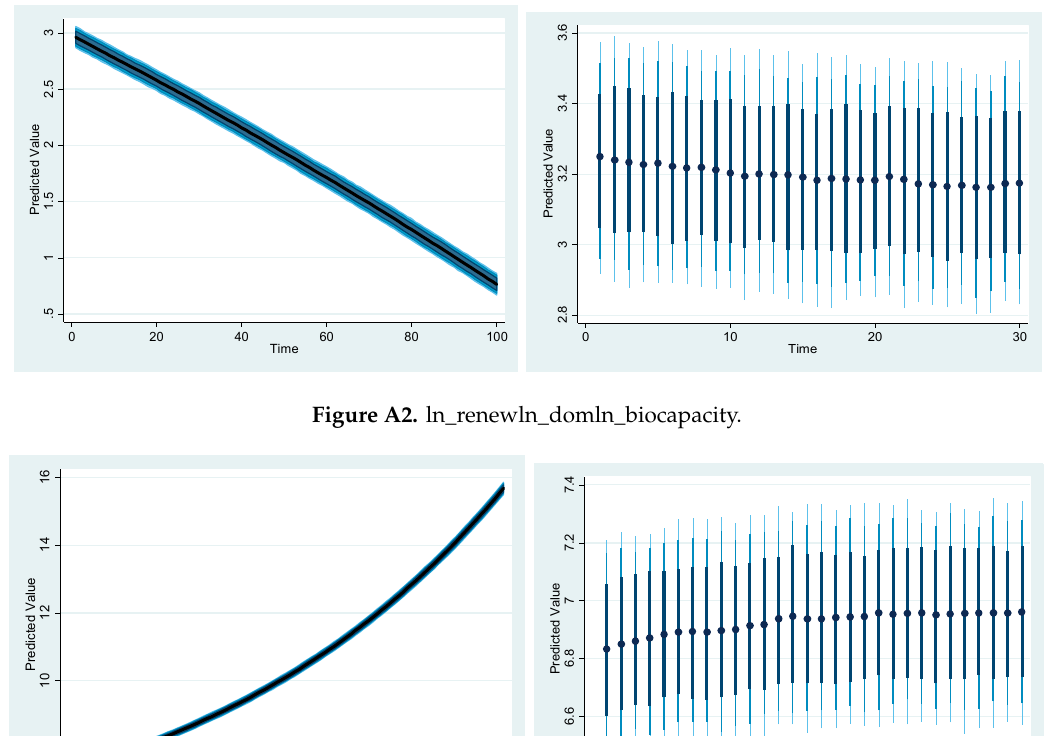
Figure A1. ln_fossileln_domln_biocapacity.